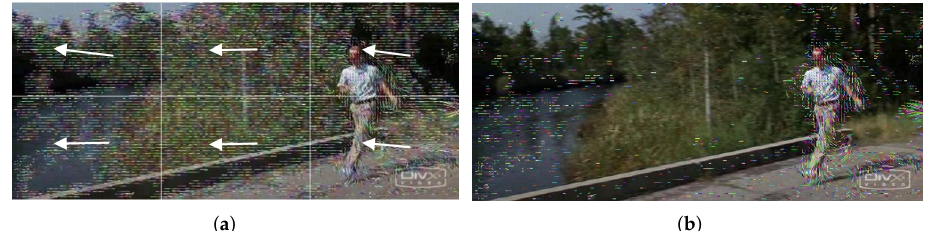
Figure 13. Illustration of the optimized optical flow field. ( a ) Initial optical flow field. ( b ) Optimized optical flow